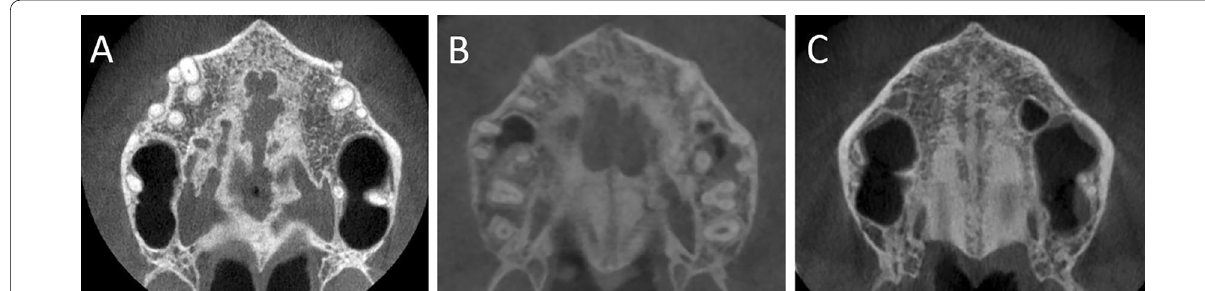
Fig. 3 Examples of scores 1 to 3 for midpalatal bone repair after MARPE. A Score 1: incomplete bone repair in the midpalatal suture covering less than 50% of the hard palate; B Score 2: incomplete bone formation in the midpalatal suture with more than 50% of the hard palate demonstrating bone repair; C Score 3: complete repair of the midpalatal region extending from the anterior to the posterior region of the hard palate